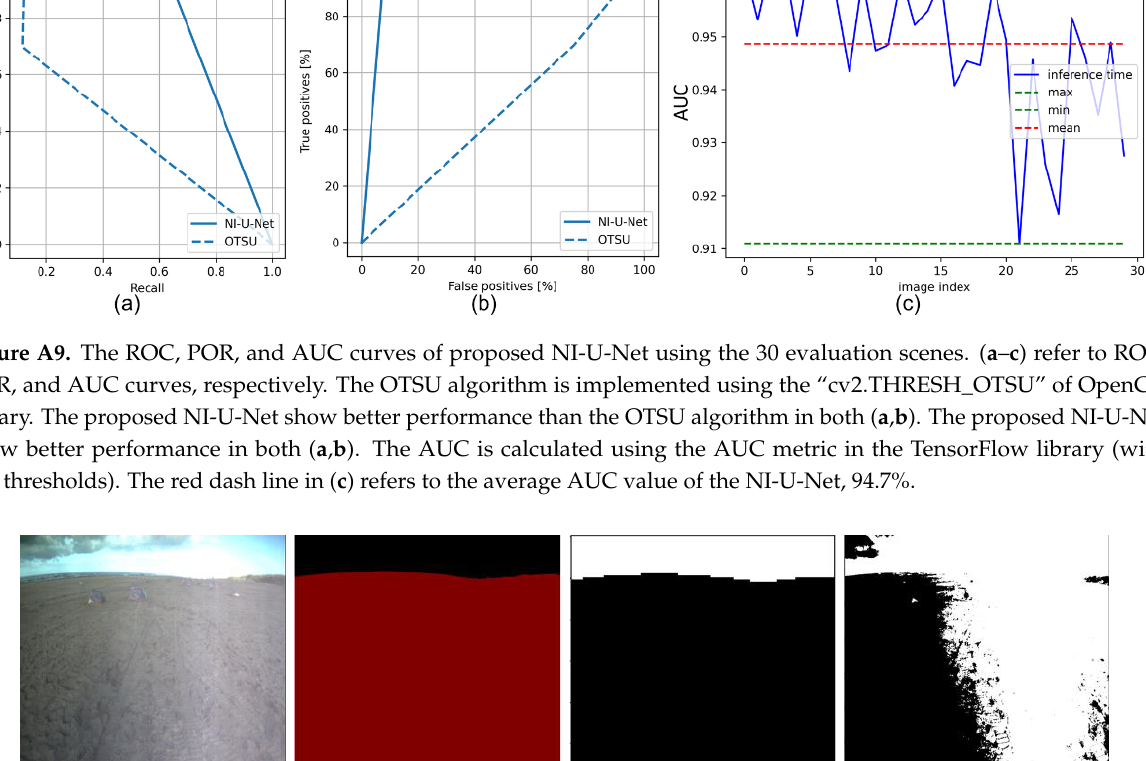
Figure A10. The visualization of the segmentation results of the proposed NI-U-Net and classical method OTSU method. Figure A8 shows the OTSU has better speed in segmentation time, while its segmentation performance is not as good as the proposed NI-U-Net.